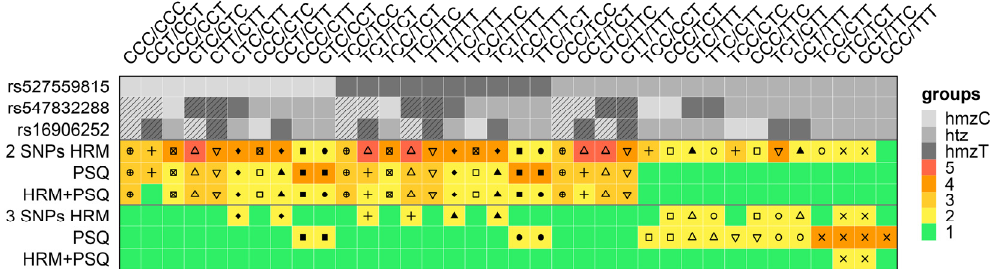
Figure 4. Comparison of genotype discrimination between the 2 SNPs and 3 SNPs assay, by taking results from HRM analysis and PSQ into account either separately or together (HRM+PSQ). Genotypes of the SNPs from the 36 oligonucleotide controls are shaded in gray for homozygous C (light), homozygous T (dark) and heterozygous C/T or T/C (medium). Variants being homozygous at both loci, rs547832288 and rs16906252, are additionally shaded with hatched areas. Numbers (1–5)/colors (green to orange/red) refer to the discrimination power. 1 (green) indicates that the variant combination was unambiguously identified. 2–5 (yellow to orange/red) indicates that the group the variant combination was assigned to contain from 2 to 5 members, respectively. Members of one group are marked by the same